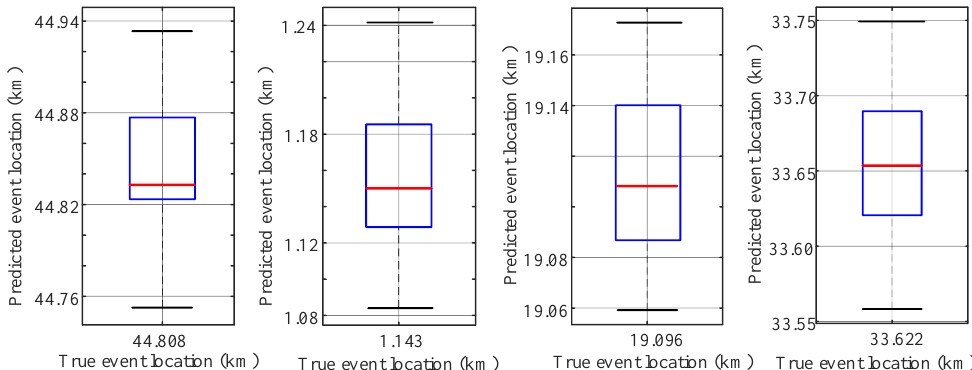
Figure 4. Boxplot which shows selected arbitrary predicted events’ positions versus true values.